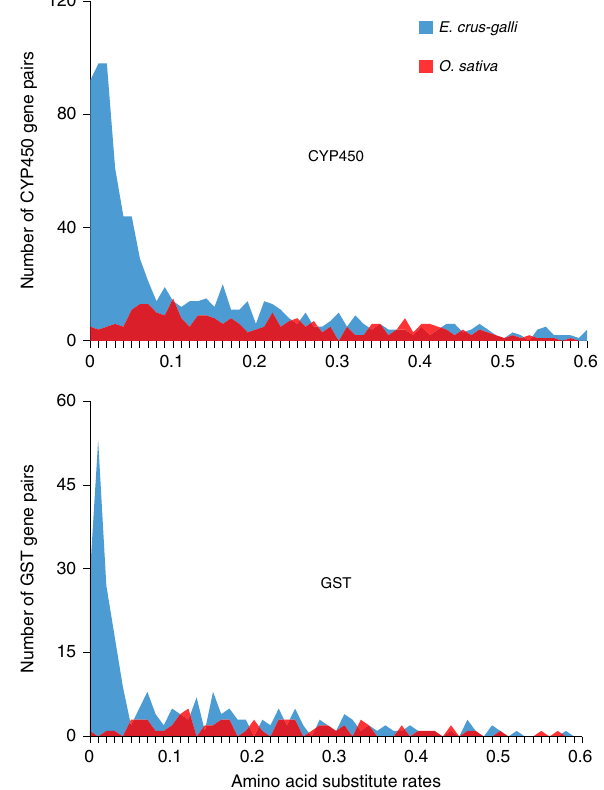
Fig. 2 Gene families associated with detoxi fi cation in E. crus-galli . Distribution of amino acid substitute rates of CYP450 and GST genes in E. crus-galli and O. sativa indicating a recent expansion of them in E.